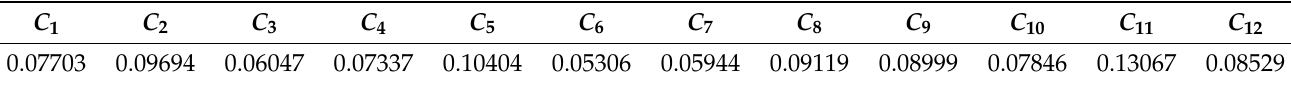
Table 3. Criteria weights determined for a small set of alternatives using the CRITIC method.